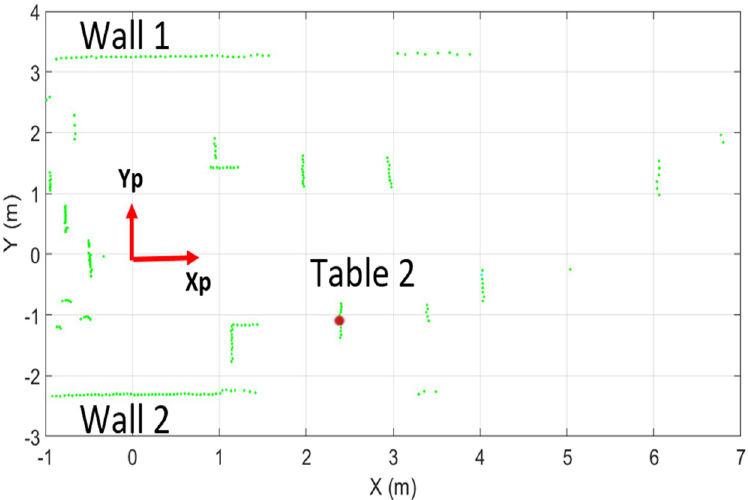
Fig 6. Laser scans of indoor environment of RPLidar